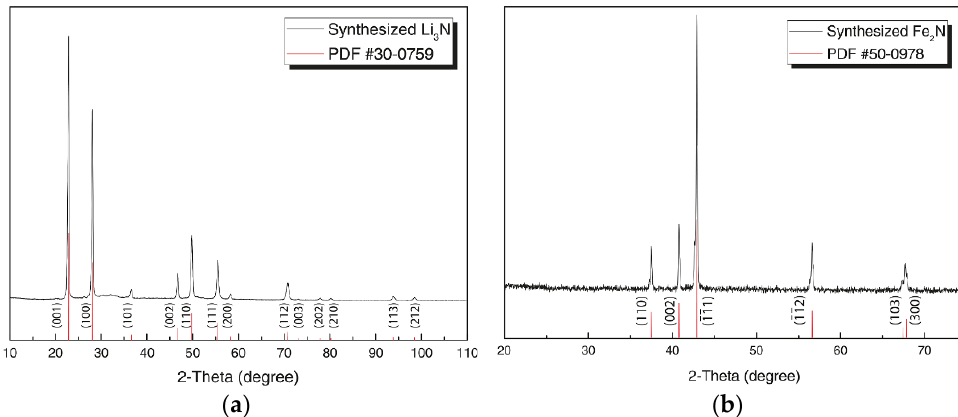
Figure 2. XRD pattern of synthesized ( a ) Li3N at 170 °C for 5 h at N2 atmosphere (709 kPa) and ( b ) Fe2N at 530 °C for 5 h at NH3 atmosphere.